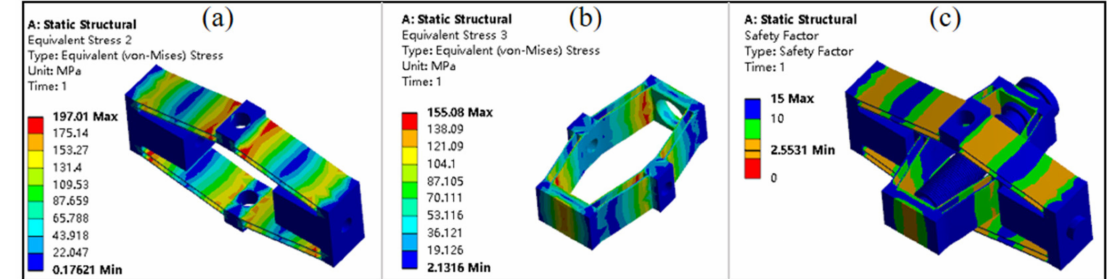
Figure 11. Stress analysis of a single rhombus frame and safety factor of a double-stage rhombus energy harvesting device. ( a ) Frame 1; ( b ) Frame 2; ( c ) Safety factor.